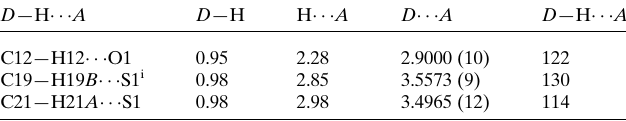
Table 2 Hydrogen-bond geometry (A˚ , (cid:3) ) for DTB.